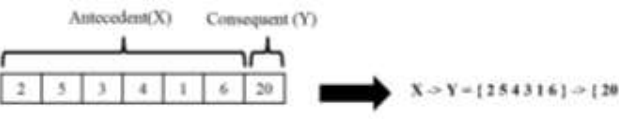
Figure 4. Examples of the S3PSO particle position and velocity.